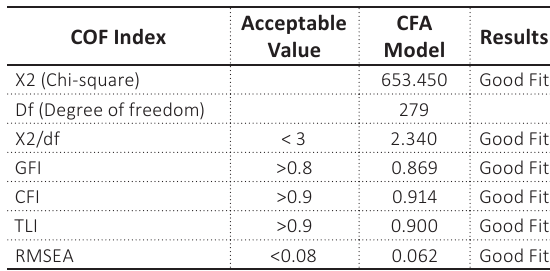
Source: Own calculations.